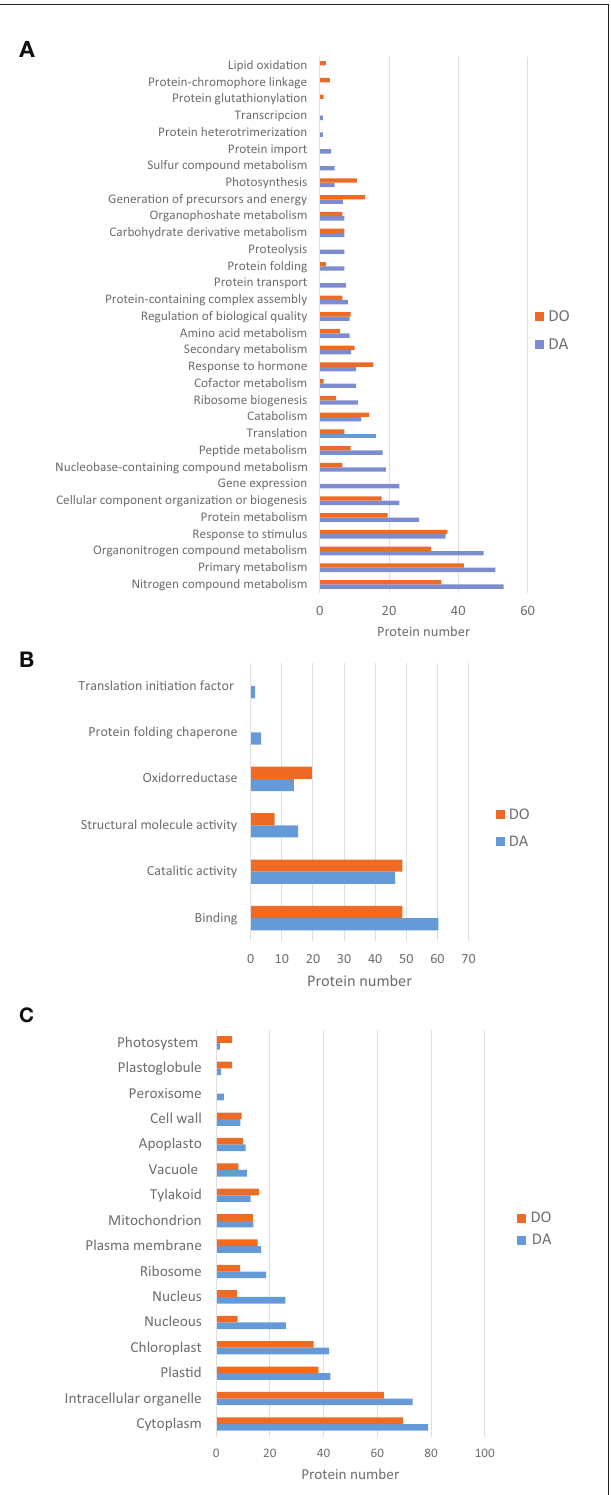
FIGURE 4 | GO classification of proteins differentially upregulated in the apogamous fern Dryopteris affinis and its sexual relative D. oreades , in the three main categories: (A) biological function; (B) molecular function; and (C) cellular